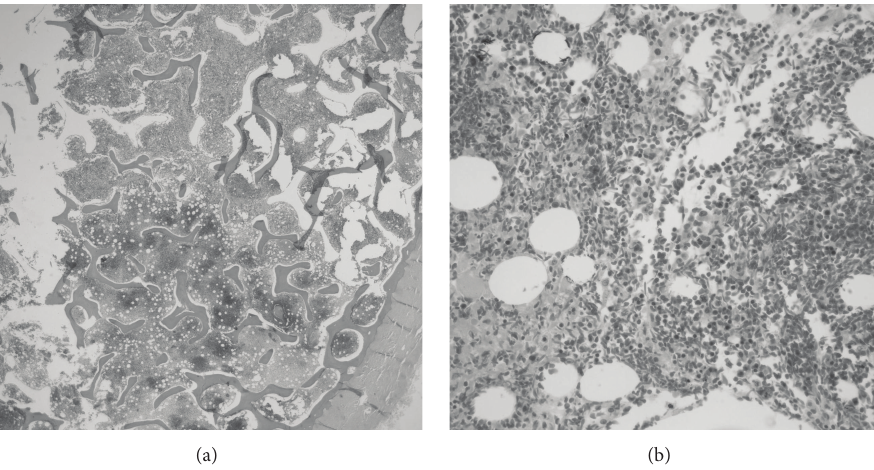
Figure 2: (a) The lower portion demonstrates the necrotic bone marrow compared to the upper viable marrow (2x original magnification, H&E stain). (b) The border of the viable and necrotic marrow shows sickling of red cells (40x original magnification, H&E stain).